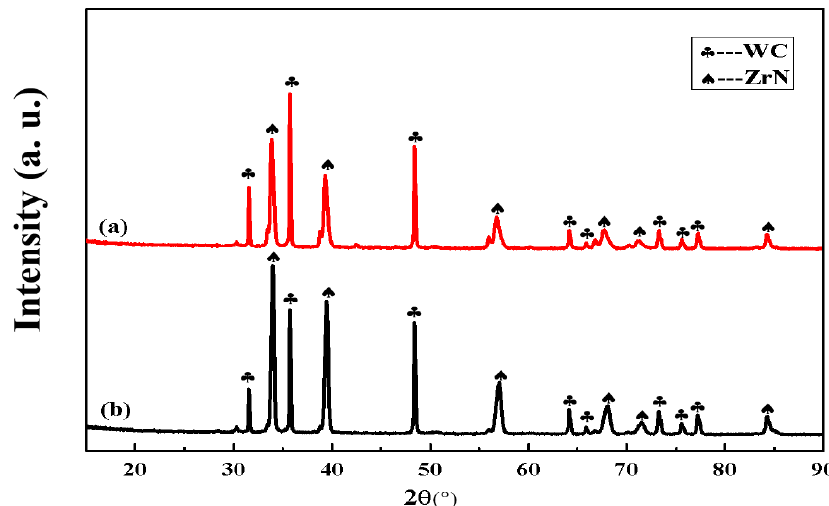
Figure 3. Microstructure and EDS element mapping of FN1-2, ( a ) microstructure, and ( b – f ) respective element mappings of Zr, W, N, Ni, and C.